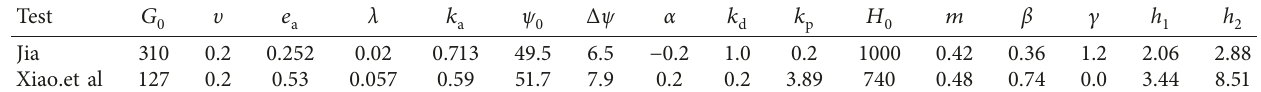
Table 3: State-dependent generalized plasticity model parameters.